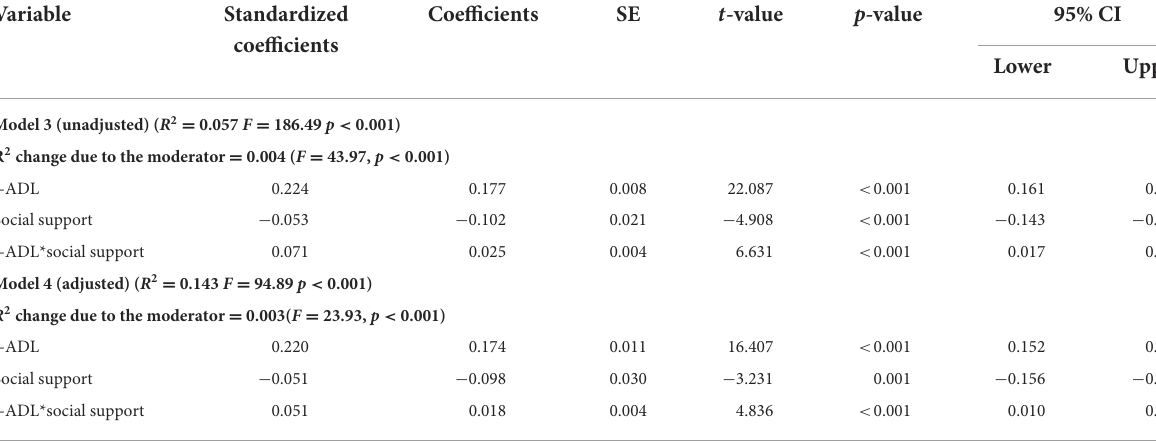
TABLE 3 Moderation analysis of social support for the association between I-ADL and depressive symptoms. Variable Standardized Coefficients SE t -value p- value 95% CI coefficients